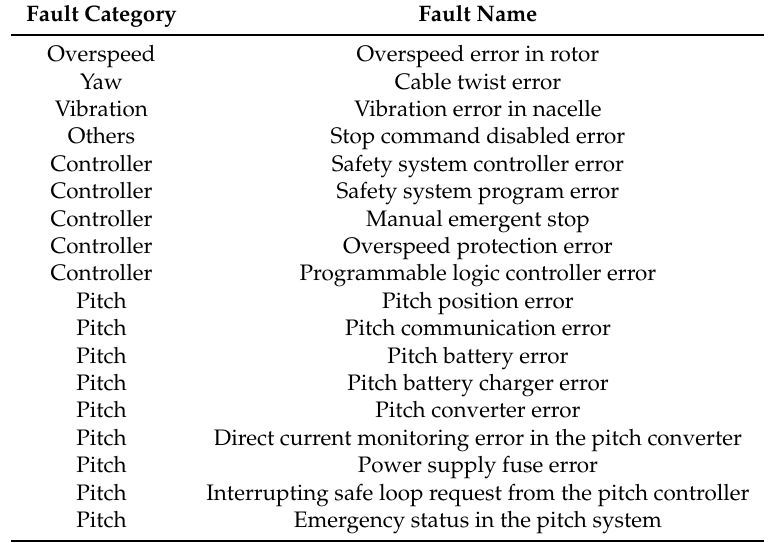
Table 2. Error variables to interrupt the safe loop.